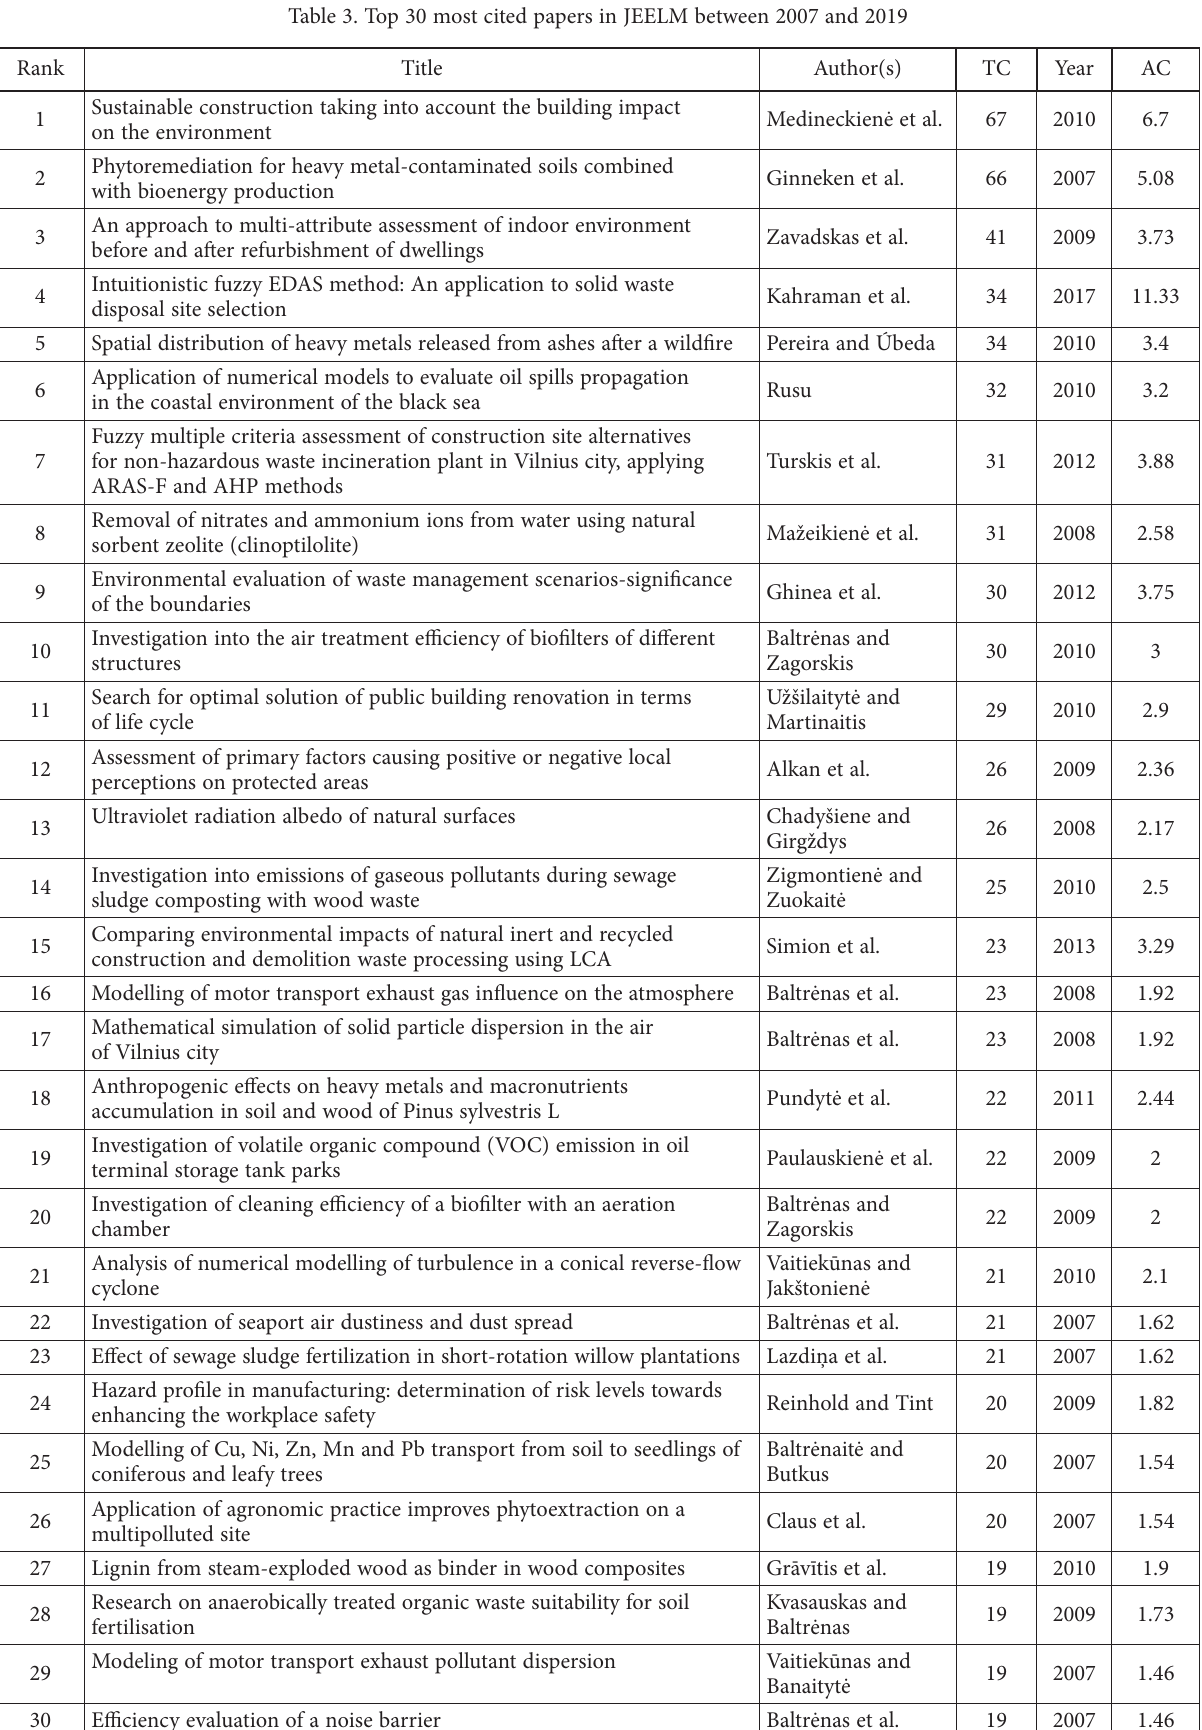
Table 3. Top 30 most cited papers in JEELM between 2007 and